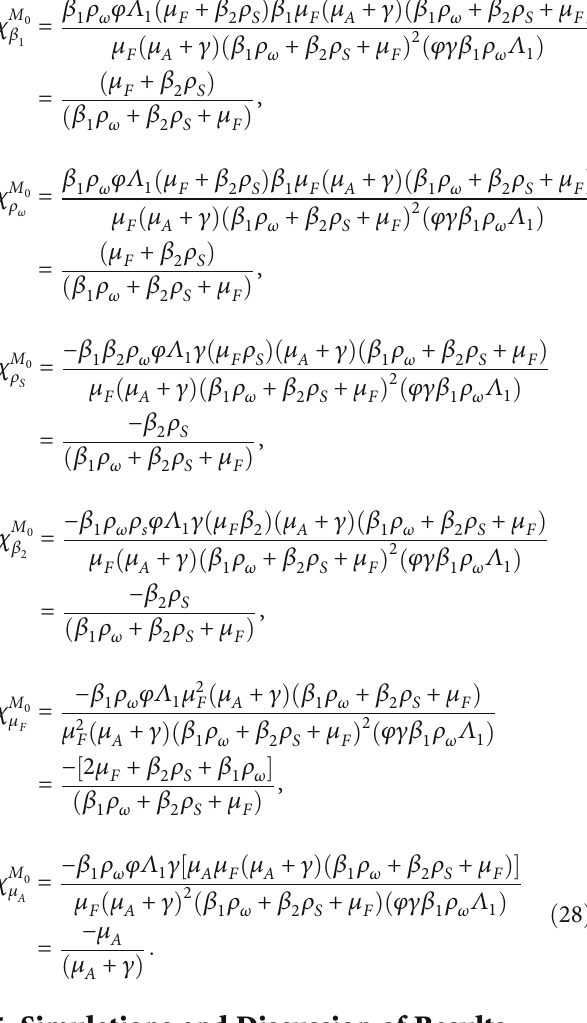
Table 3: Numerical values of variables/parameters